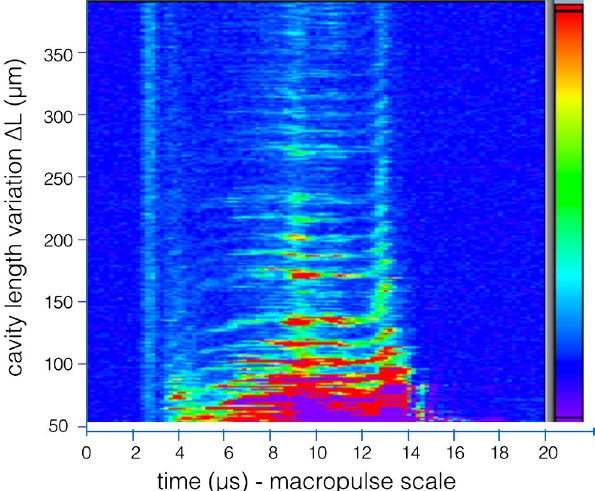
FIG. 2. Intensity of undulator radiation vs time, at the macro- pulse timescale, for various positions of cavity length (no laser occurs here because out of range), at radiation wavelength λ ¼ 31 . 7 μ m.